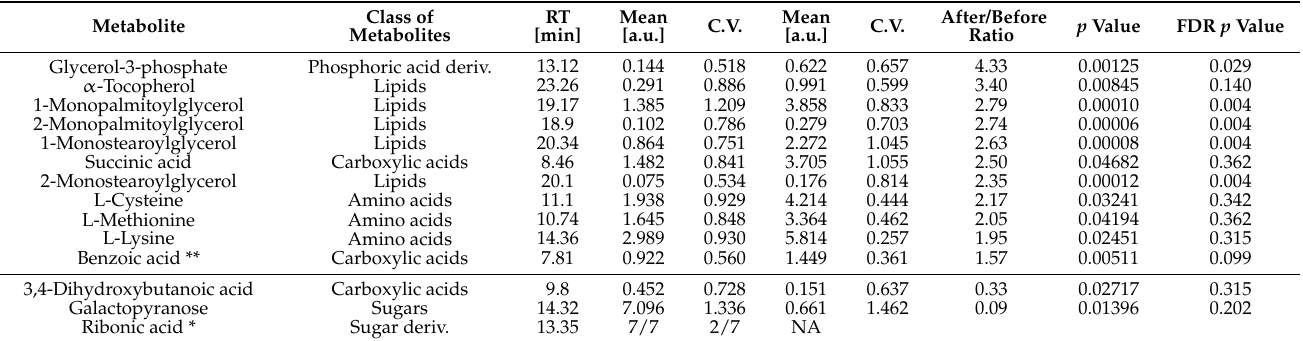
Table 3. Statistical analysis of clinical characteristics of patients in the